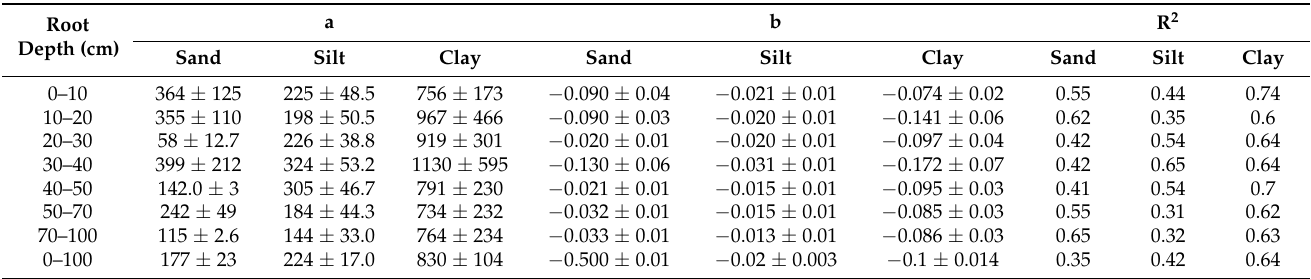
Figure 5. Carbon (mg C g soil − 1 day − 1 ) evolved from the decomposition of vetiver root biomass of seven depth increments in three soils during 206 days. Where vetiver root biomass used from the glasshouse experiment and incubated at 25 °C constant temperature. Plots show the raw data (o), a fitted exponential model (–) and 95% confidence bands. Table 4. Rate of carbon evolvement from vetiver below ground biomass decomposition (mg C g soil − 1 day − 1 ) in three soils. Values of the intercept (a), the slope (b) and Coefficient of determination (R 2 ).